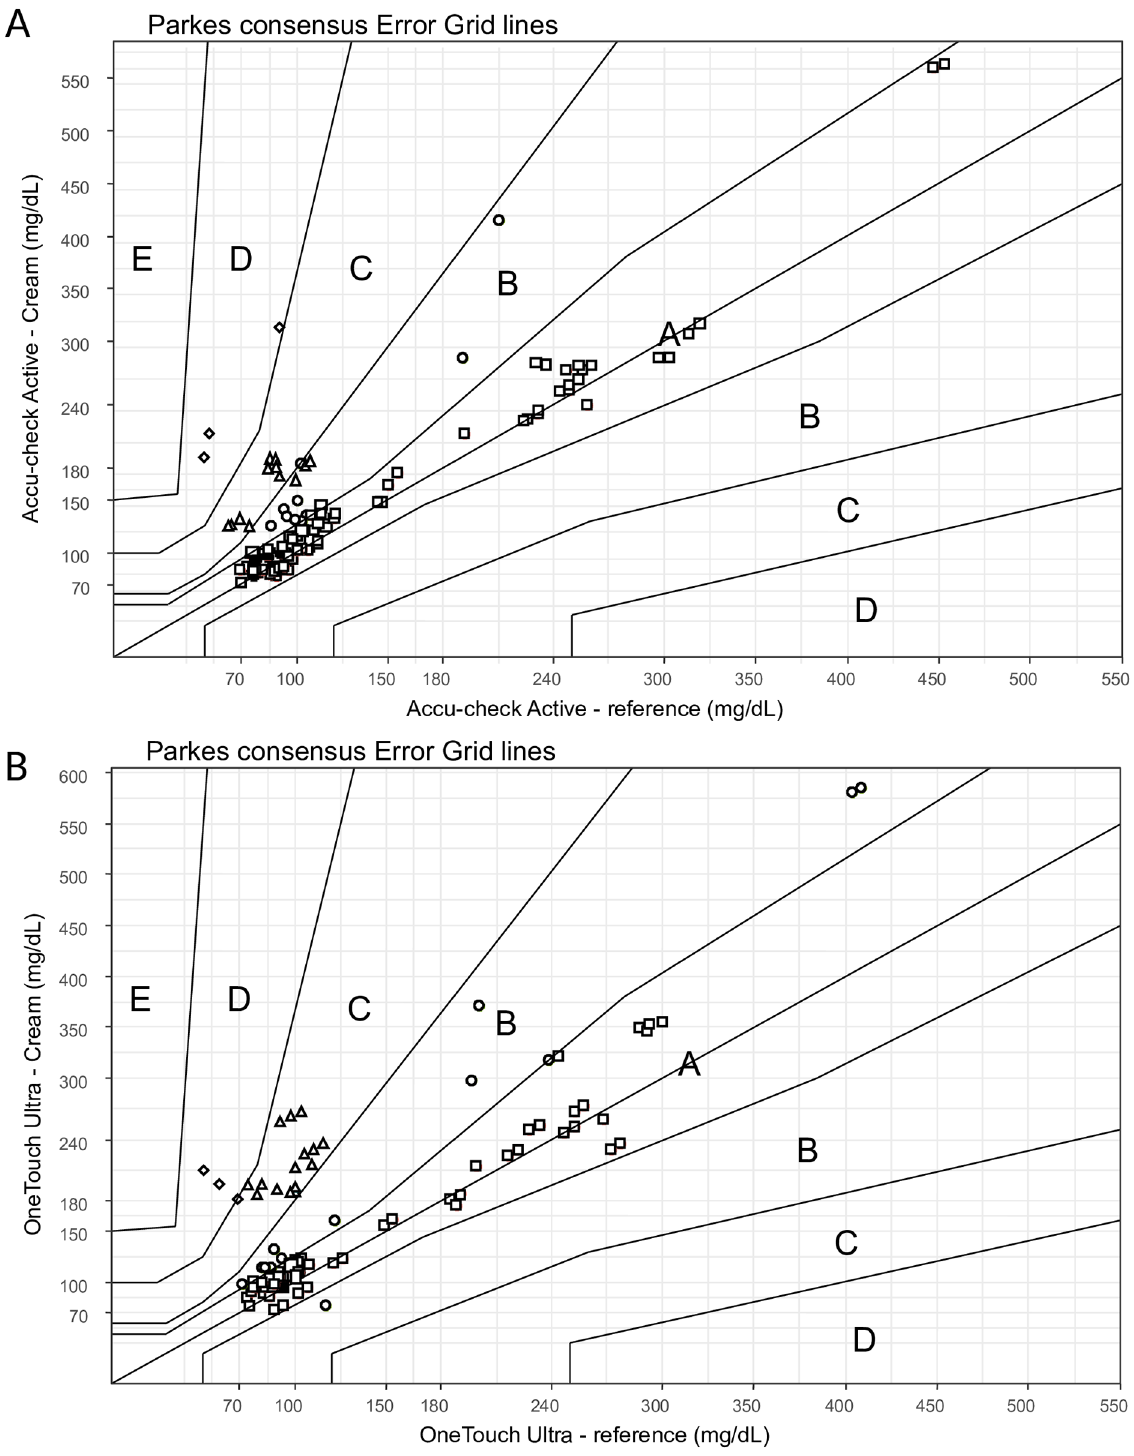
Fig 2. Parke’s error grid analysis comparing the reference capillary glucose measurement against the value obtained after hydroquinone-containing cream application. 2A: Accu-check Active; 2B: OneTouch ultra2. Open squares are in zone A, open circles in zone B, open triangles in zone C and open diamonds in zone